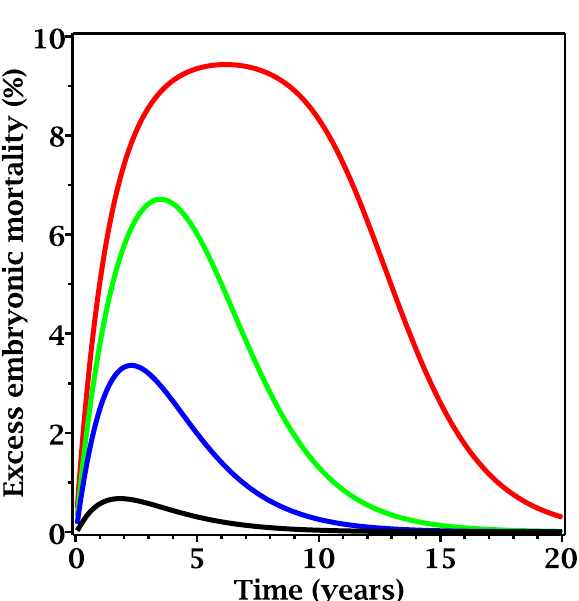
Figure 4. Predicted radiation responses as function of time since the start of exposure to different time- dependent dose rates based on best-fit model parameters for plant ( Arabidopsis thaliana ) data. In all curves, the time needed for dose rate to decrease by twofold is 1 year. Red curve: initial dose rate = 10,000 µGy/h. Green curve: initial dose rate = 100 µGy/h. Blue curve: initial dose rate = 10 µGy/h. Black curve: initial dose rate = 1